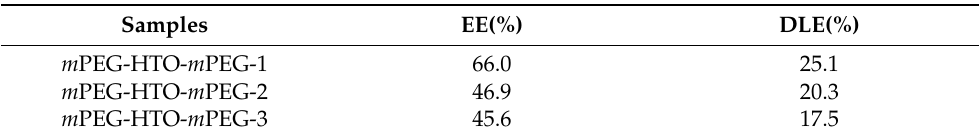
Table 2. The entrapment efficiency (EE) and drug loading efficiency (DLE) of prednisone acetate- loaded m PEG-HTO- m PEG